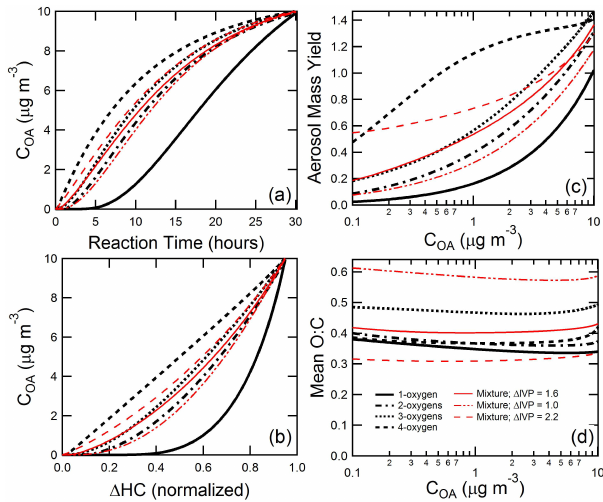
Fig. 7. The (a) temporal evolution of the aerosol mass, (b) variation of C OA with the amount of SOA precursor reacted, (c) variation of aerosol yield with C OA , and (d) variation of O:C with C OA shown for the addition of 1, 2, 3 or 4 oxygen atoms per reaction for a N C = 12 SOA precursor over 3 lifetimes of oxidation, assuming 1 LVP = 1.6. Results are also shown assuming P func = [0.25, 0.25, 0.25, 0.25] with 1 LVP = 1.0, 1.6 or